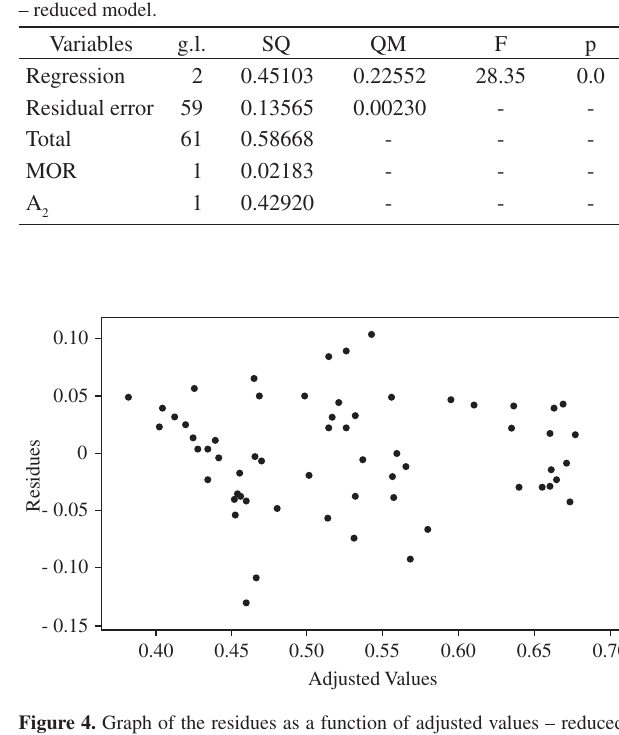
Figure 3. Graph of normal probability of the residues.